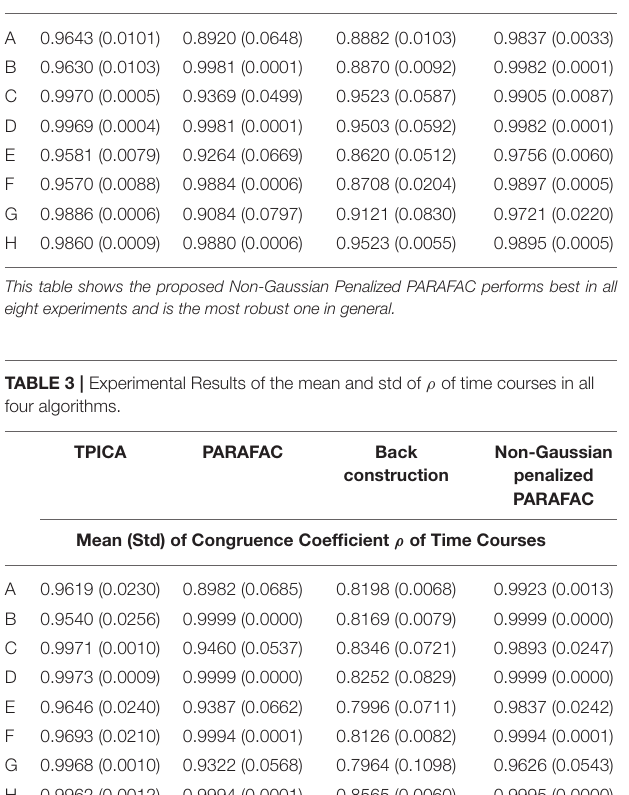
Non-Gaussian construction penalized PARAFAC